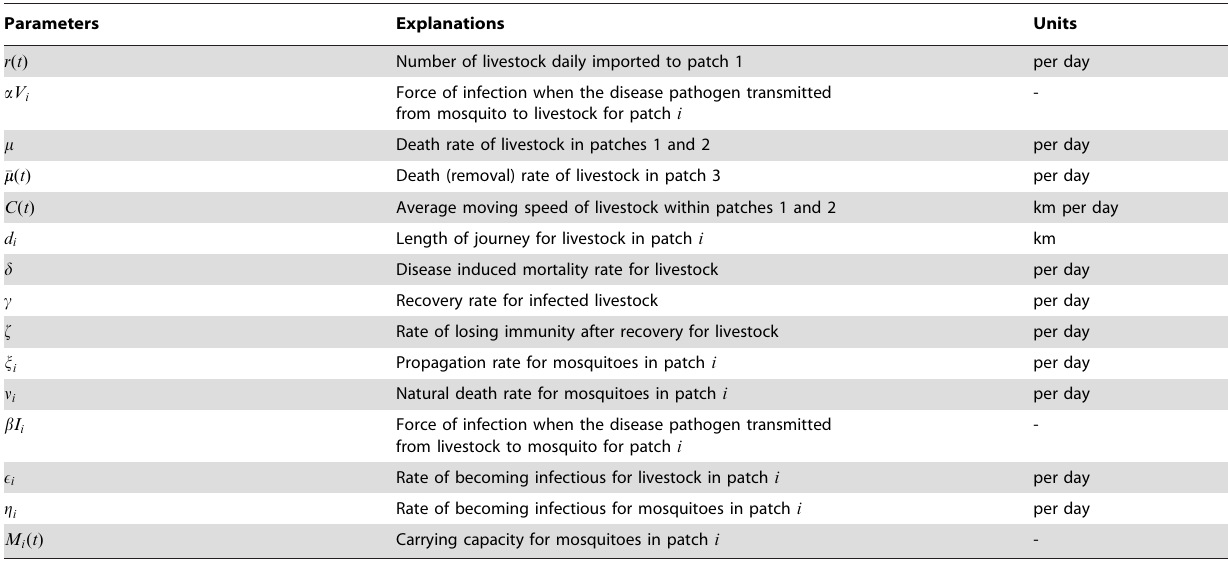
Table 2. Parameters in the